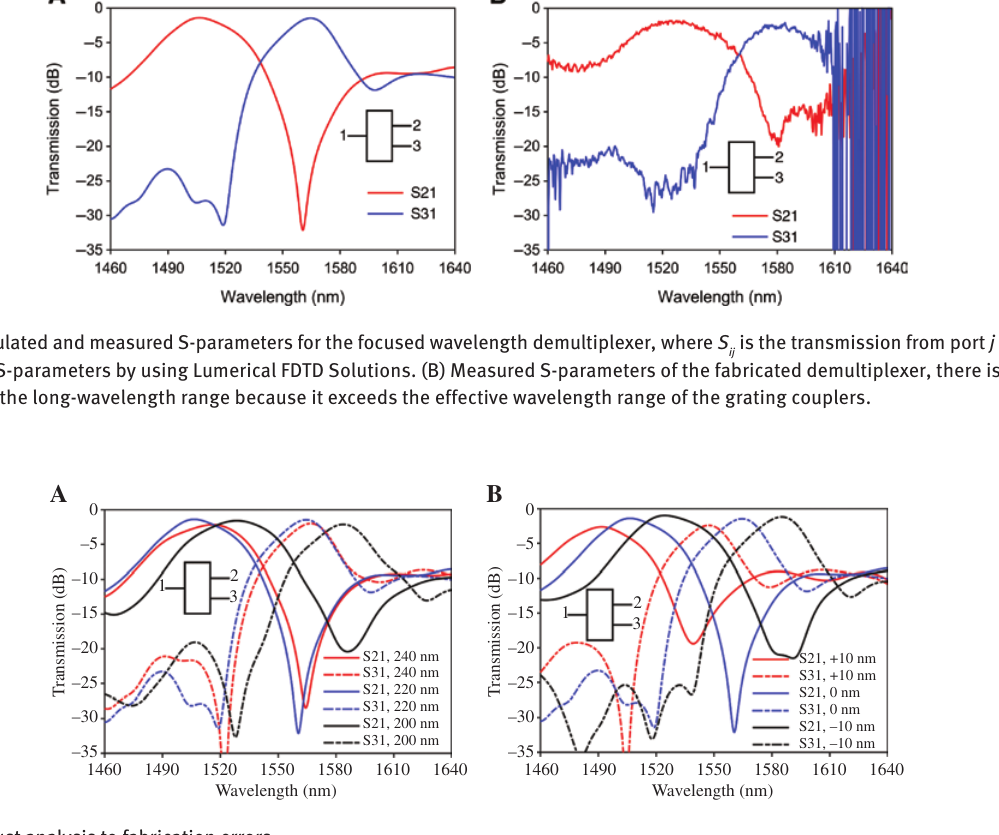
Figure 5: Robust analysis to fabrication errors. (A) Simulated S-parameters with etching depth to be 240 nm (red), 220 nm (blue) and 200 nm (black). (B) Simulated S-parameters with plane size changing of + 10 nm (red), 0 nm (blue) and −10 nm (black). The solid (dashed) line represents the S-parameters of the upper (lower)